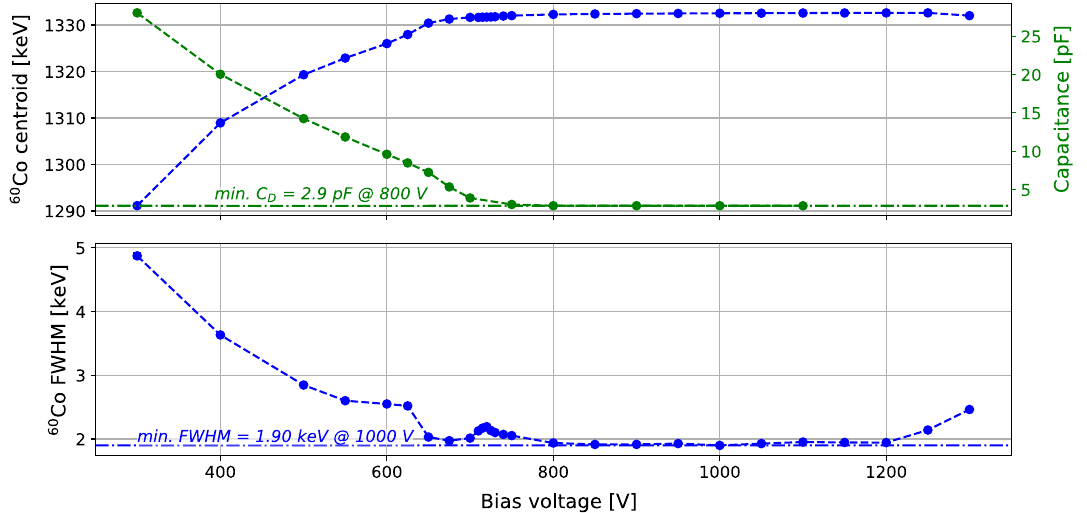
Fig. 3 Voltage scan of the prototype detector. The upper panel shows the centroid of the 1332 . 5keV 60 Co peak. It stopped changing its posi- tion above 750V – the value is closely correlated with the depletion voltage determined from the C–V curve (upper panel, green curve).